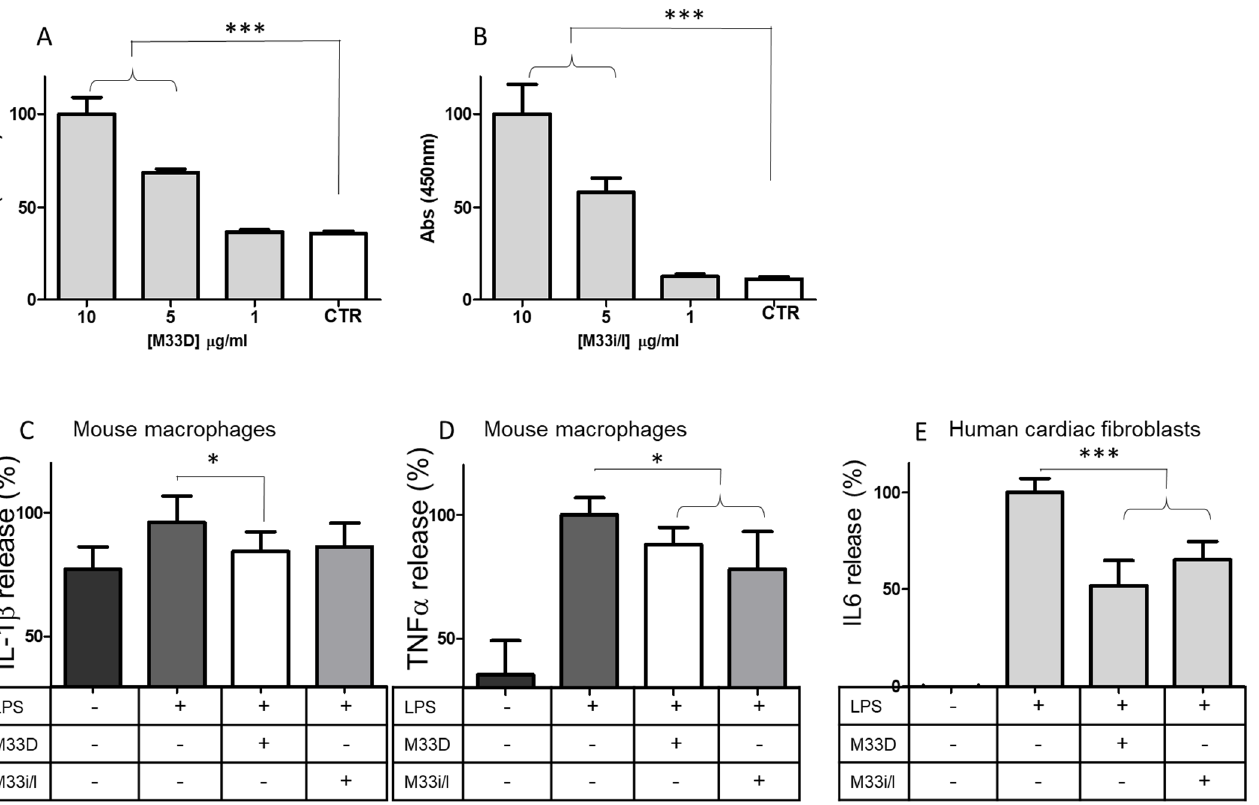
Figure 4. ( A ) M33D and ( B ) M33i/l binding to LPS (n = 6, for all groups, *** p < 0.0001). ( C ) IL 1 β (n = 4 in the first group, 8 in the second, 6 in the third and fourth, * p = 0.0348) and ( D ) TNF α (n = 4 in the first and second group, 6 in the third and 4 in the fourth, * p < 0.05) release in LPS-stimulated RAW 264.7 macrophages in the presence of the peptides. ( E ) HCF release of IL6 in the presence of M33D and M33i/l (n = 3, *** p < 0.0001). Maximum IL6 release was 2.29 µ M calculated from a linearized standard curve.